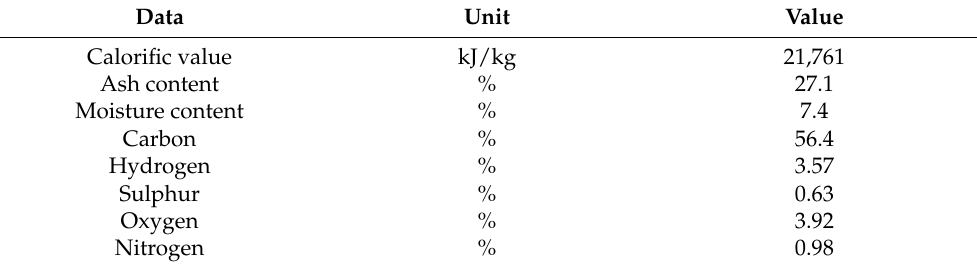
Table 4. Coal parameters (as received).